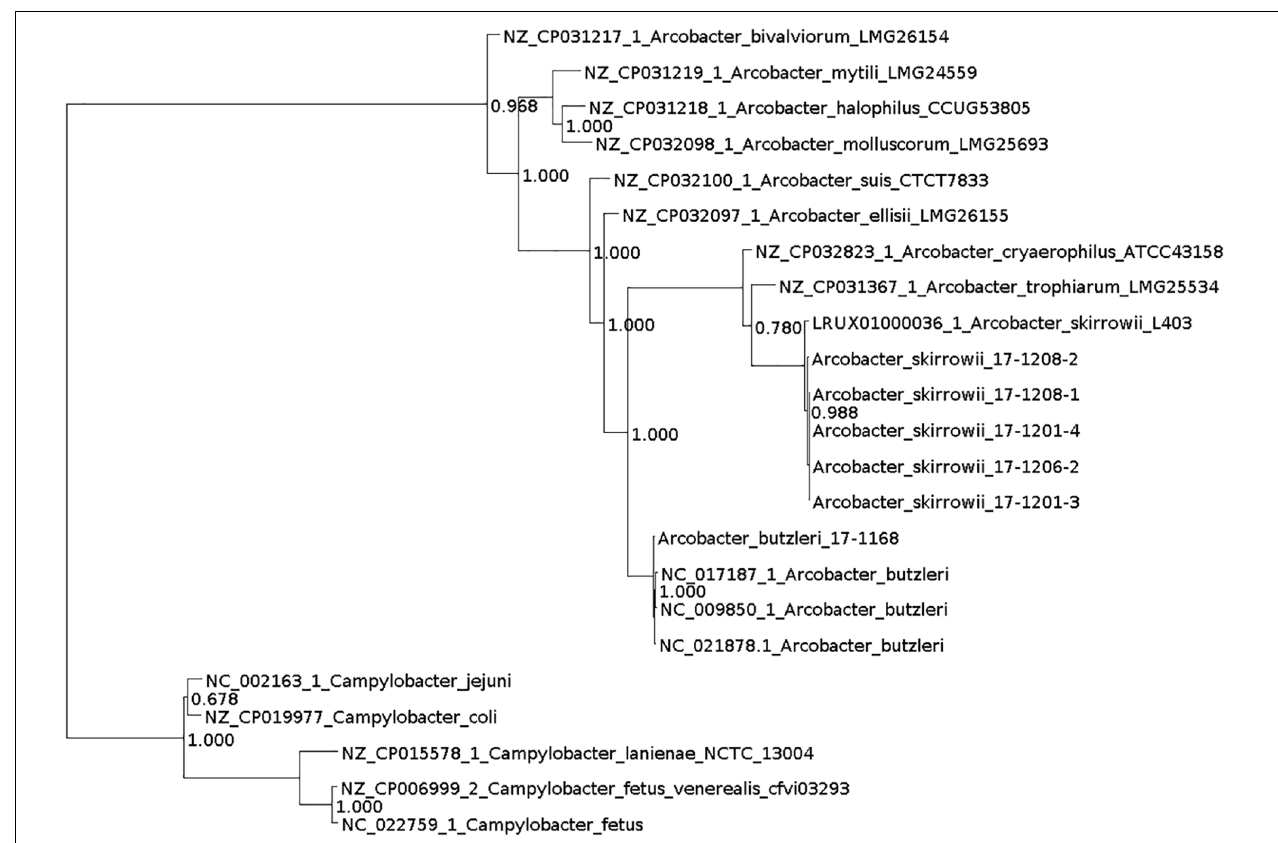
FIGURE 1 | Phylogenetic tree generated with PhyloPhlAn and visualized with